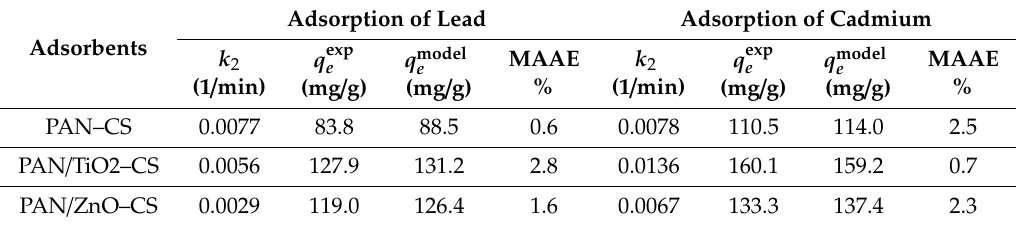
Figure 7. Comparison of the predicted adsorption capacity of ( a ) lead and ( b ) cadmium ions obtained by the PSO model against the corresponding experimental results for the bilayer PAN–CS and PAN / MO–CS nanofibers. Table 1. Kinetic parameters used by the PSO model to determine the adsorption of lead and cadmium by the bilayer nanofibers. The mean errors between the model and the experiment are